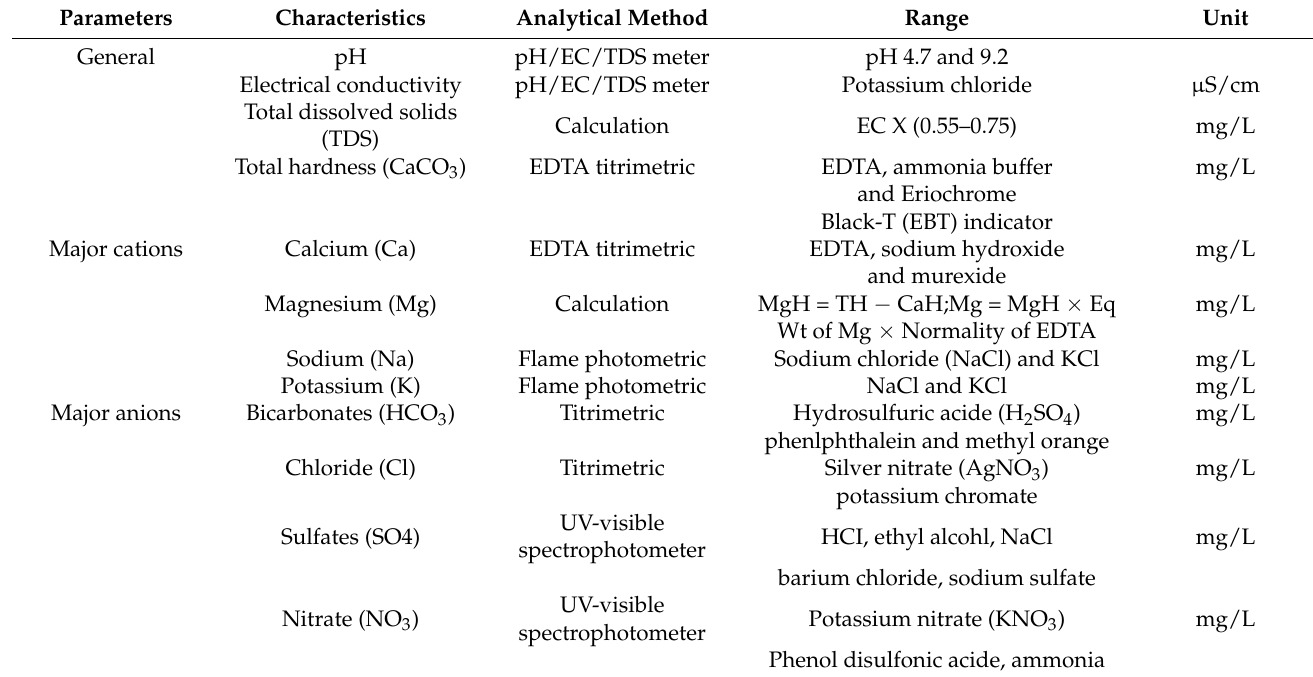
Table 1. Instrumental and titrimetric techniques used for the chemical analysis of samples of sur- face